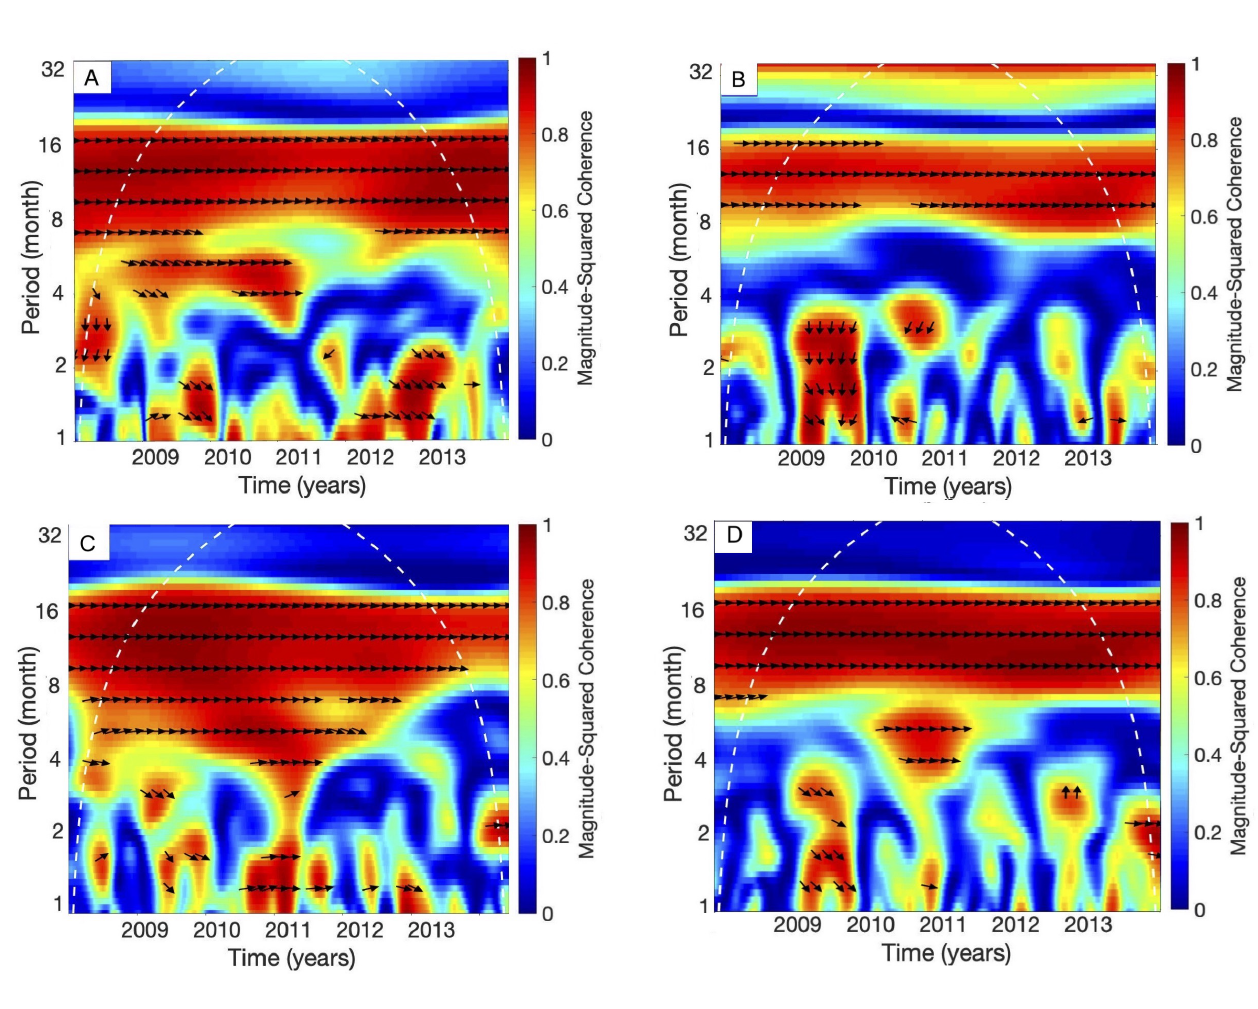
Figure 5. Squared wavelet coherence between the CAPE and rainfall (2008–2013) for TUCU ( A ) and CATA ( B ) stations and between the GNSS-IWV and rainfall (2008–2013) for TUCU ( C ) and CATA ( D ) stations. The arrows indicate the lag phase relation between rainfall and CAPE and rainfall and